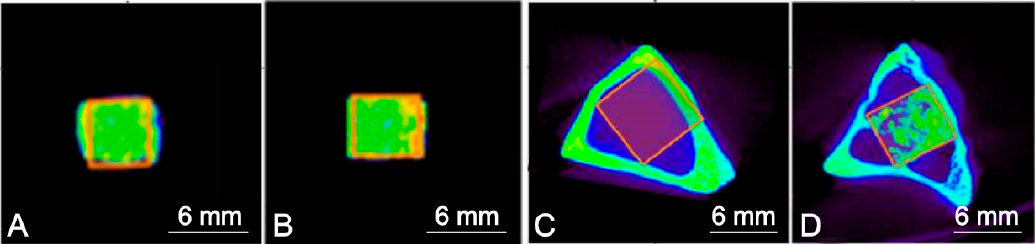
Figure 3. ROIs of ( A ) the CSP scaffold, ( B ) the DBM-coated CSP, ( C ) the rabbit tibiae before implantation,